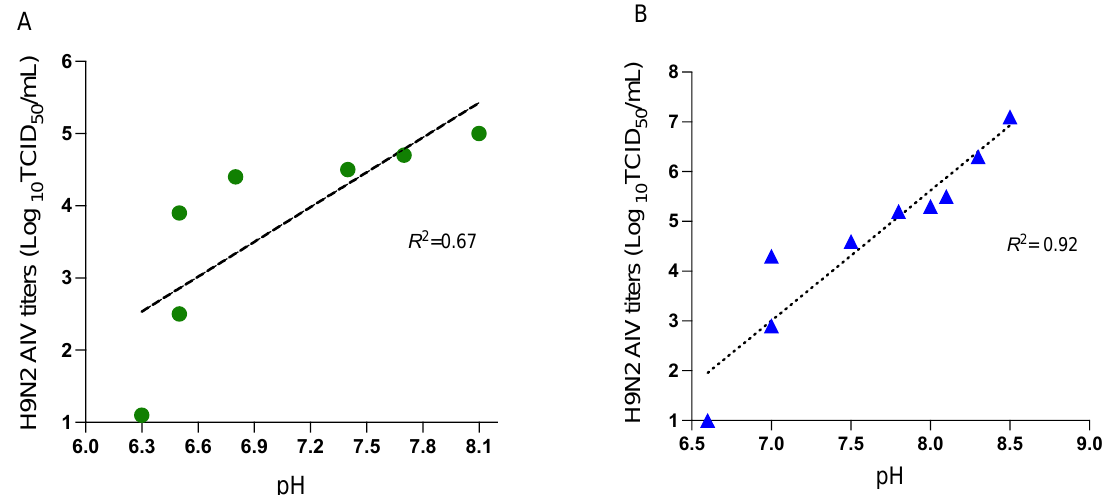
Figure 2. Correlation of H9N2 AIV viability in the context of pH in models A and B: Correlation between H9N2 AIV titers (log 10 transformed) and pH in fecal droppings from infected birds in model A ( A ) and experimentally spiked fecal droppings in model B ( B ) were determined post-exposure (PE) at different time points using Pearson’s correlation test. Scatter plots illustrate the magnitude of correlation between the H9N2 AIV titers (TCID 50 /mL) and pH at different time points in both the models.